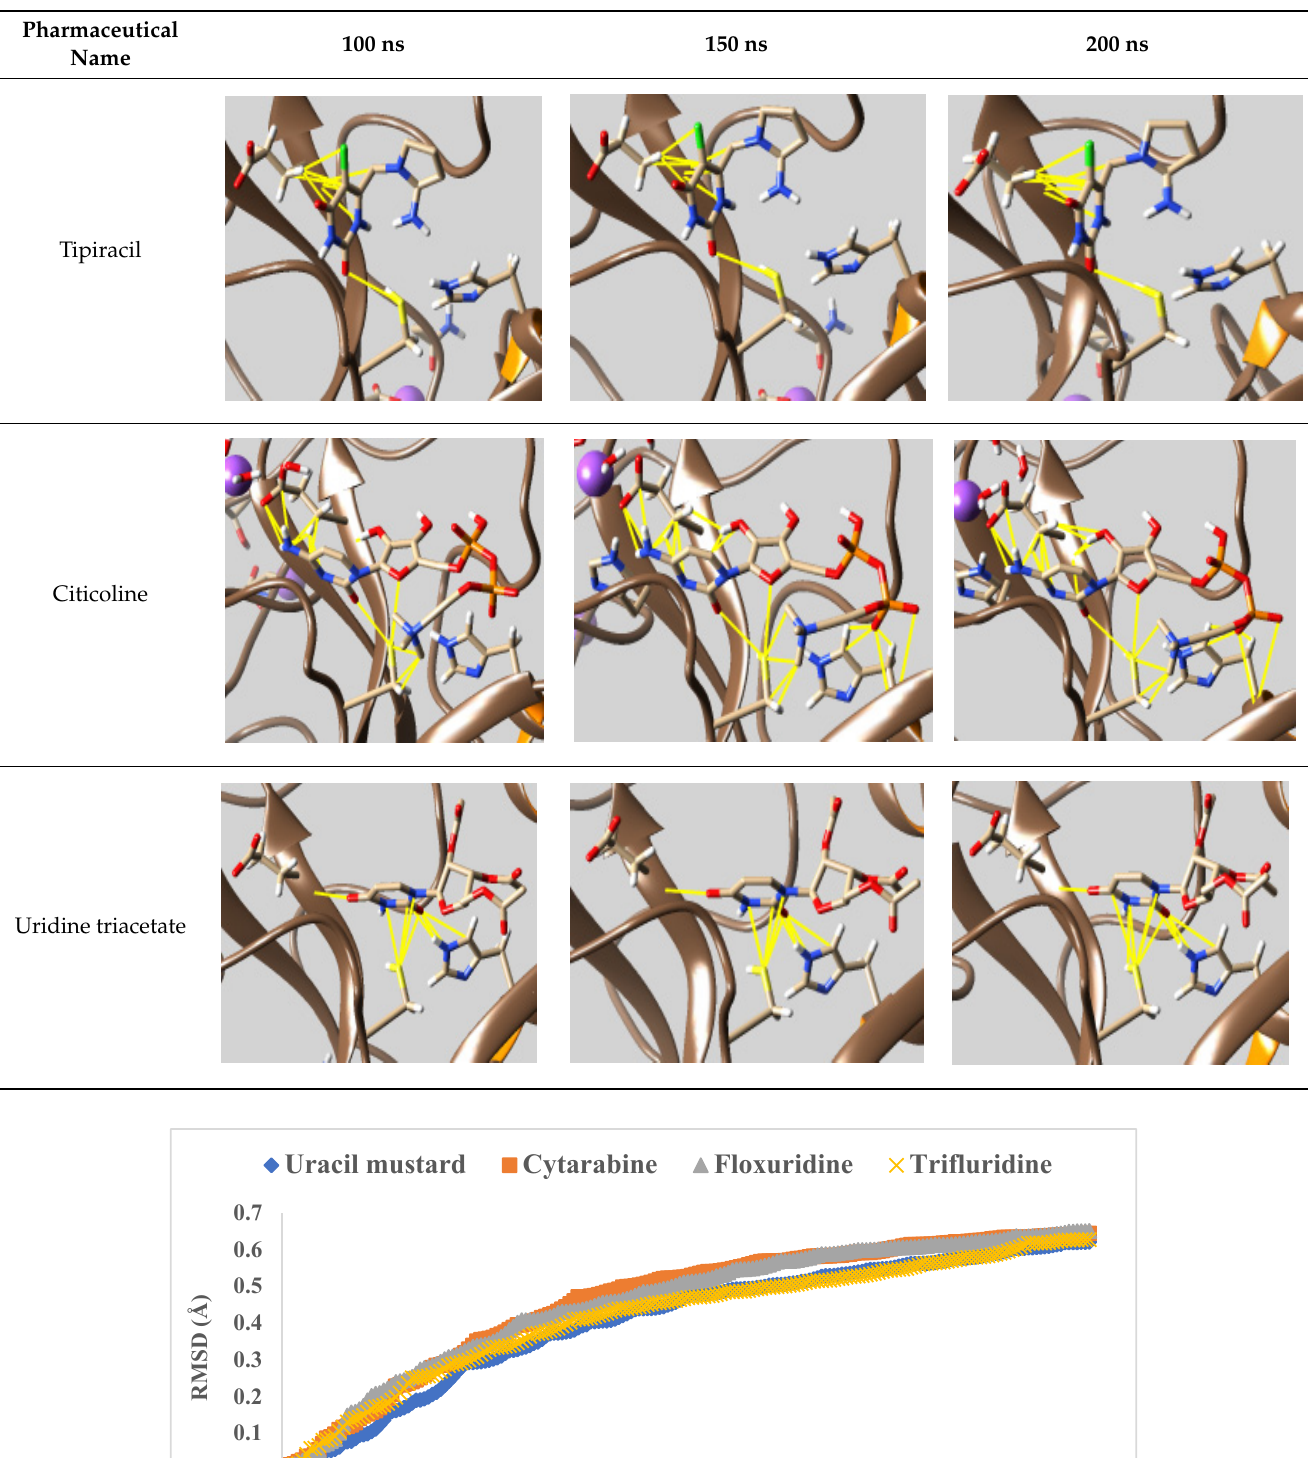
Figure 3. The RMSD values of the simulated PP-3CL pro complexes throughout the 200 ns production runs.